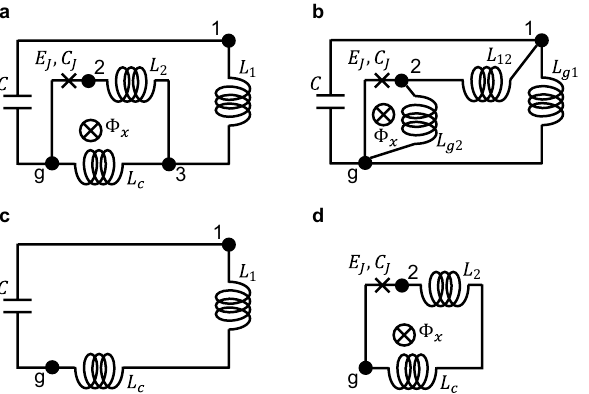
Figure 1. Circuit diagrams. ( a ) A superconducting circuit in which a single-Josephson-junction flux qubit and an LC oscillator are inductively coupled to each other by a shared inductor. ( b ) Equivalent circuit obtained by applying the so-called Y- (cid:31) transformation to the inductor network in circuit ( a ). ( c ) The outer loop of circuit ( a ), which forms an LC oscillator. ( d ) The inner loop of circuit ( a ), which forms a single-Josephson-junction flux